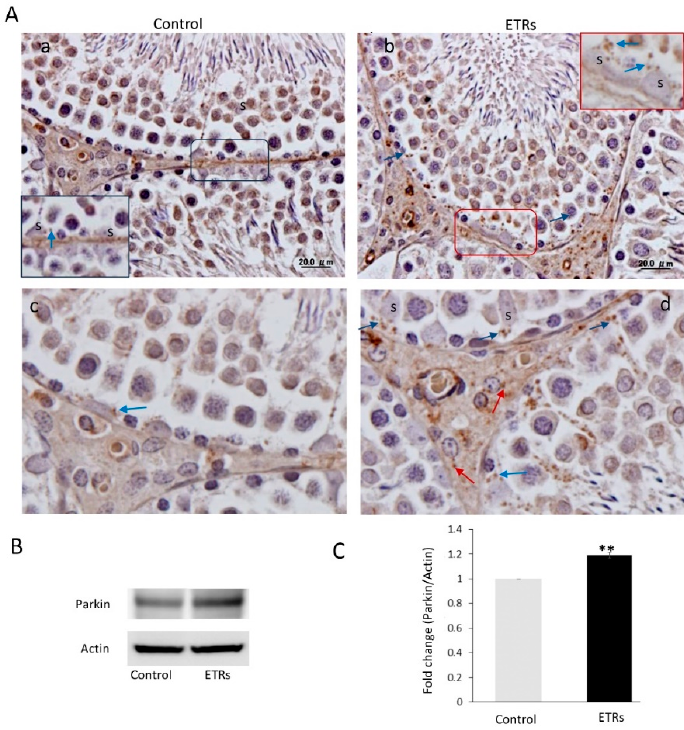
Figure 4. Ethanol-related increase in Parkin expression in SCs with predominant perinuclear localization ( A ) IHC of Parkin in the control ( a ) and ETRs ( b ). The insets are higher magnifications of the framed areas showing Parkin expression (blue arrows). The lower panels ( c , d ) are higher magnifications demonstrating Parkin expression in SCs and Leydig cells (red arrows). S: SC nuclei. ( B ) Western blot of Parkin ( n = 3). The histogram in ( C) shows a significant increase in Parkin expression in ETRs. ** p < 0.01 ( t -test).